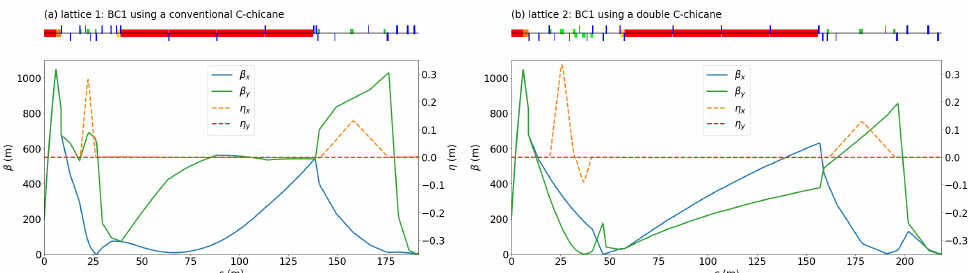
Figure 2. The evolution of the Twiss parameters, along the beamline for ( a ) lattice 1 using a con- ventional C-chicane as BC1 and ( b ) lattice 2 using a double C-chicane as BC1. An overview of the lattice elements is provided at the top of the respective plot. Note that the profiles of the β -functions in lattice 2 inside the section of L2 appeared unaffected by the quadrupoles because only a small focusing strength was needed in this